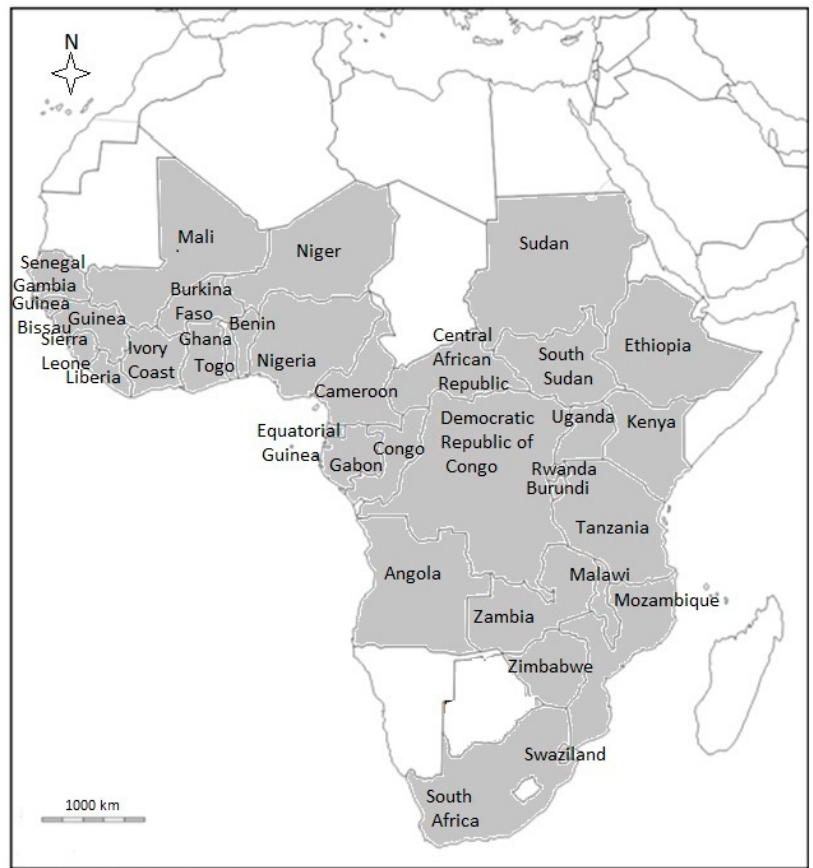
Figure 1. Distribution of B. micrantha in the mainland tropical Africa.